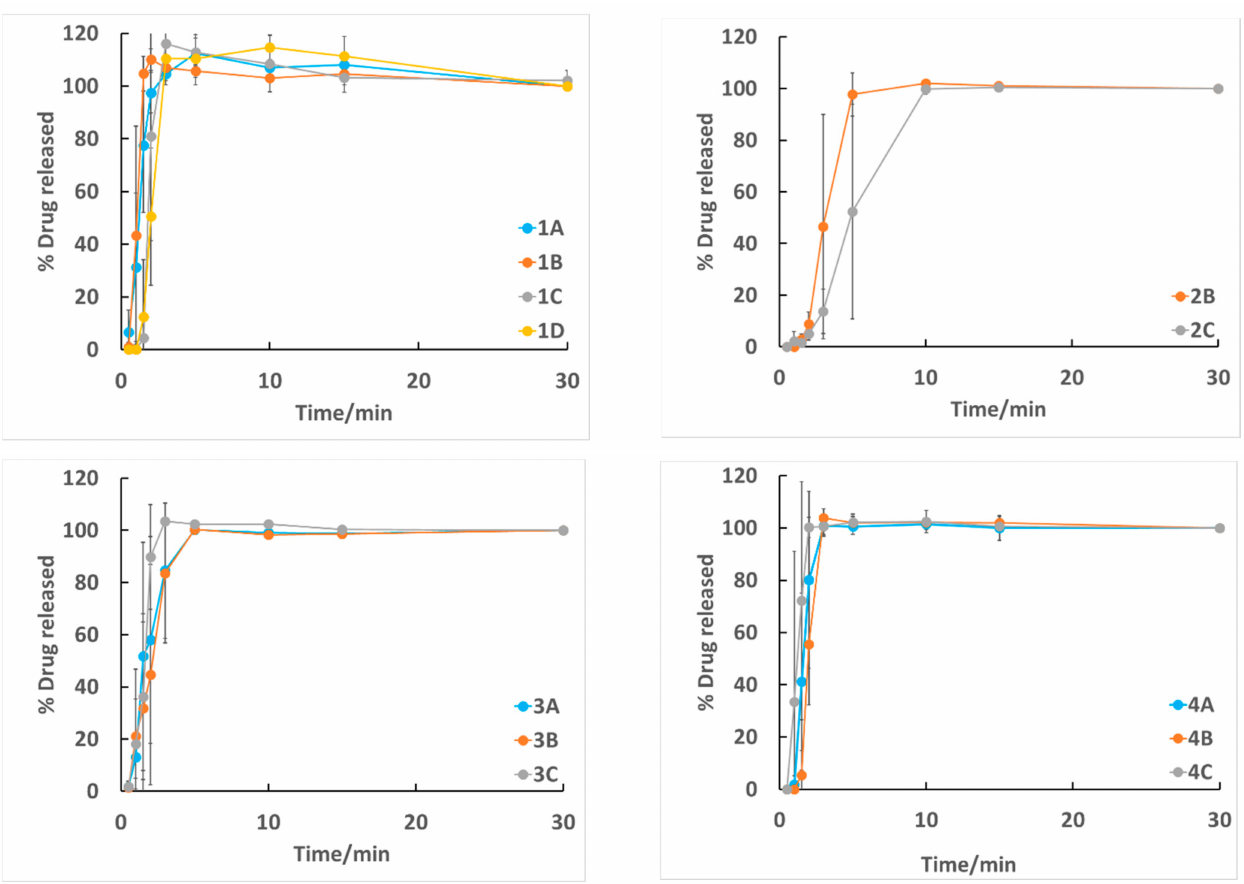
Figure 2. Drug release profiles of different film formulations (n =